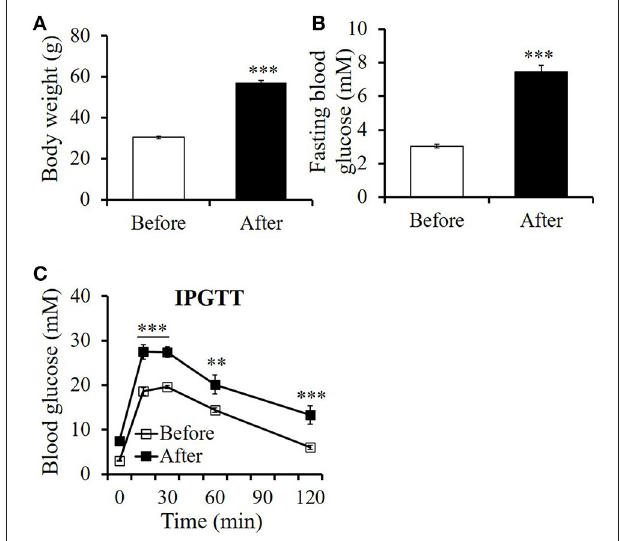
assayed by an intraperitoneal glucose tolerance test (IPGTT) before and after 6 months’ high-fat diet feeding. All values are means ± SE ( n = 11 for each group). Differences of (A) body weight, (B) fasting blood glucose between before and after HFD feeding were analyzed using paired Student’s t -test method. Differences of (C) blood glucose levels at indicated time point during IPGTT between before and after HFD feeding is analyzed using two-way RM ANOVA method. ** p < 0.01; *** p <